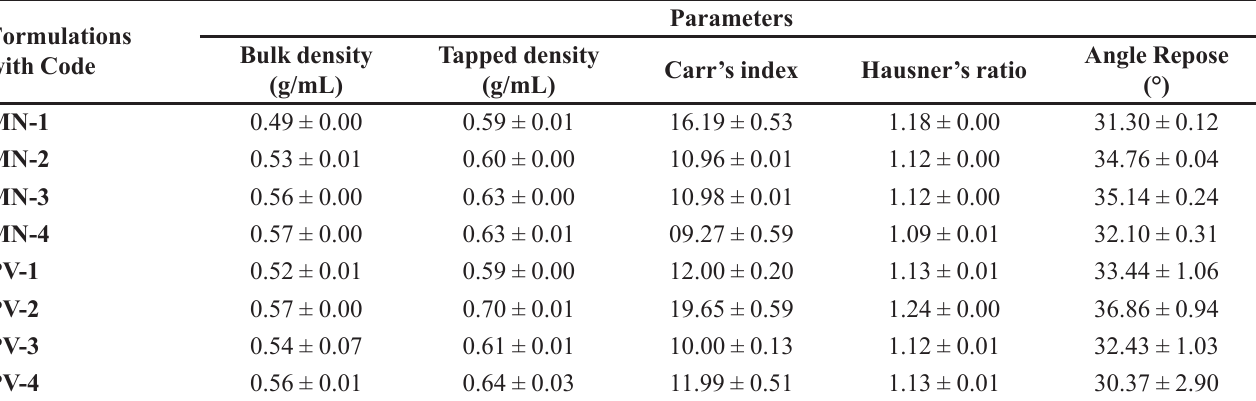
TABLE III - Physicochemical properties of